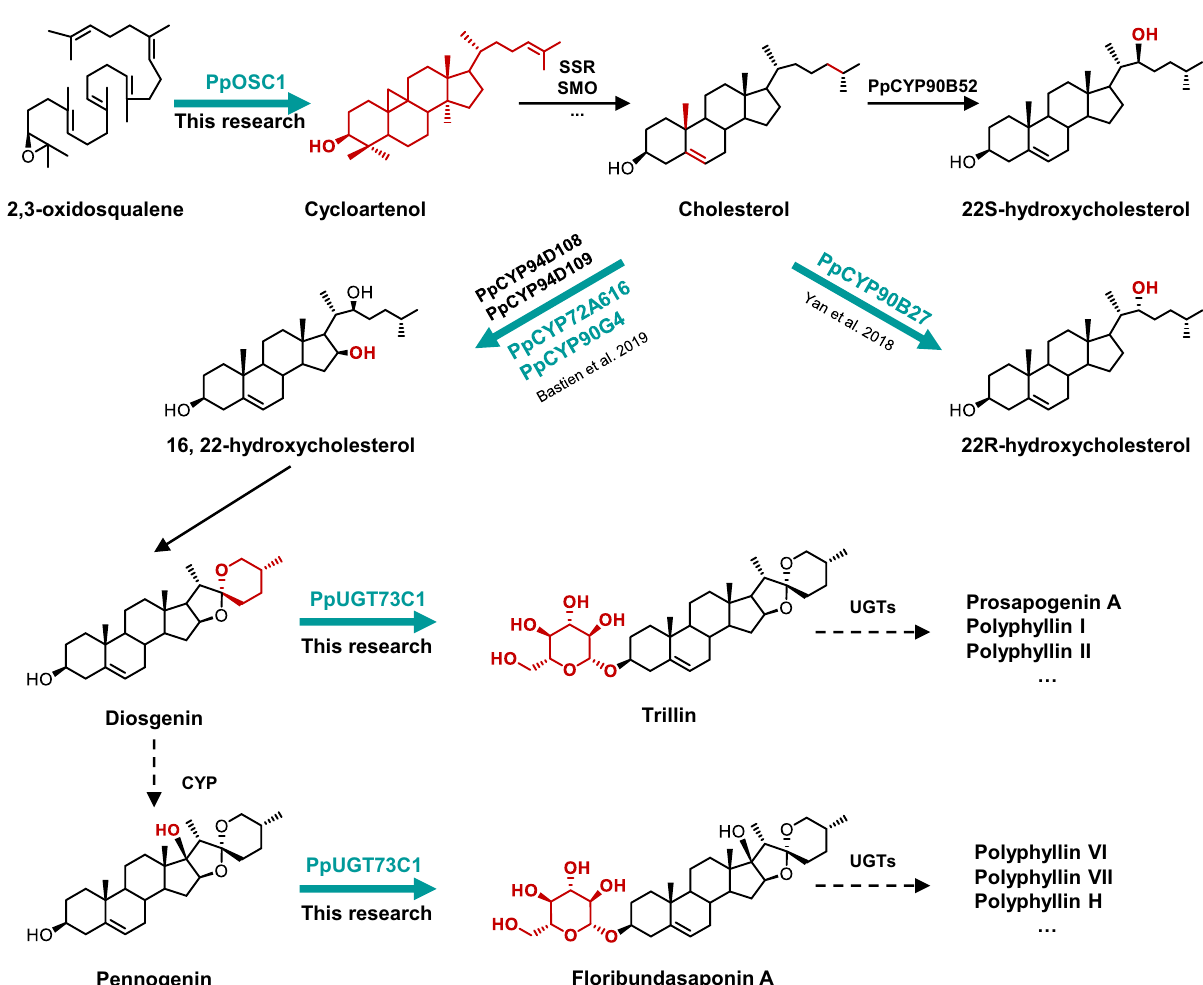
Fig. 1 Possible biosynthetic pathways of polyphyllin in P. polyphylla var. yunnanensis . The established metabolic pathways are represented by solid line arrows, while the speculated metabolic pathways are represented by dotted line arrows. Genes predicted by transcriptome, metabolite pro fi le, and WGCAN analysis are shown in the yellow background, and those identi fi ed by this method are shown in the blue